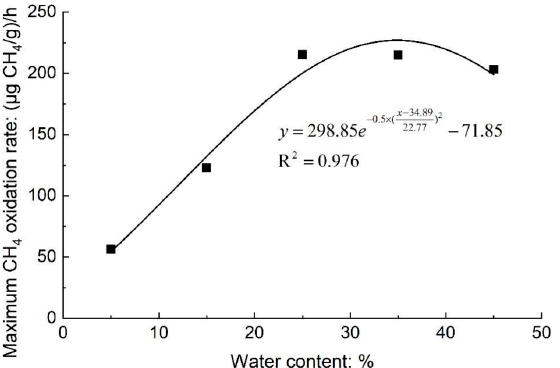
Figure 5. Relationship between maximum methane oxidation rate and water content. Figure 4. Methane oxidation rate of cover soil with different water contents versus time.